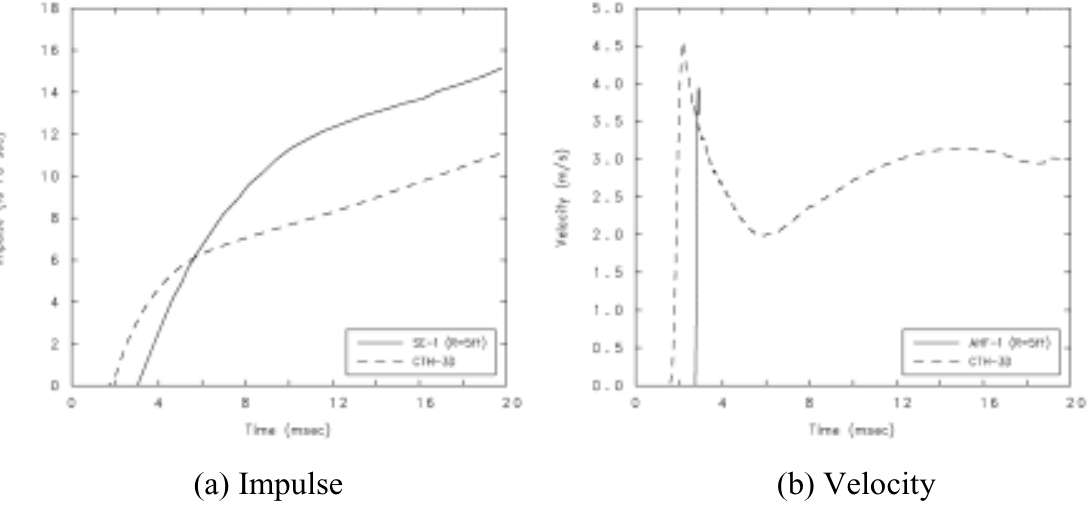
Fig. 10. Comparisons of free-field impulse and velocity at a range of 1.52 m, test 3.